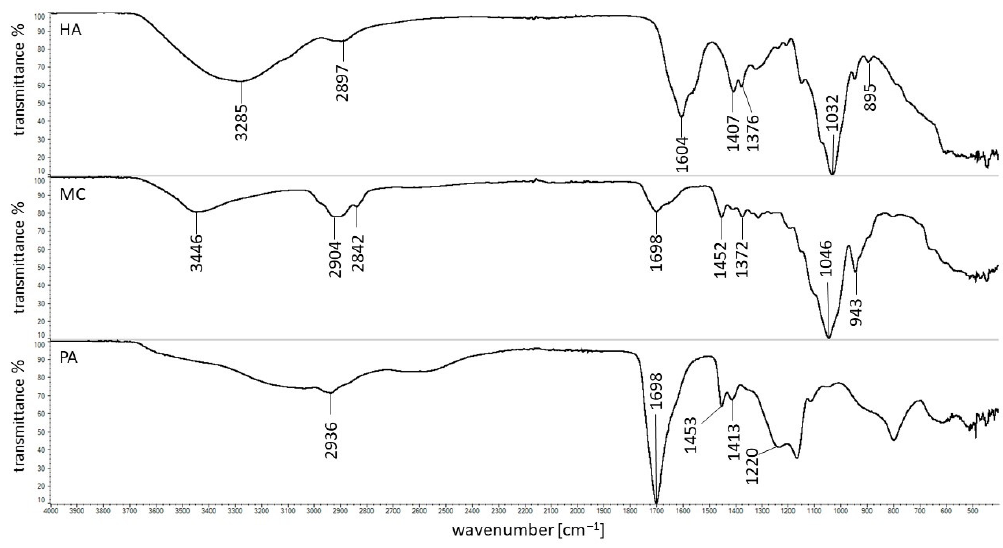
Figure 5. The FTIR spectra of pure HA, MC, and PA.